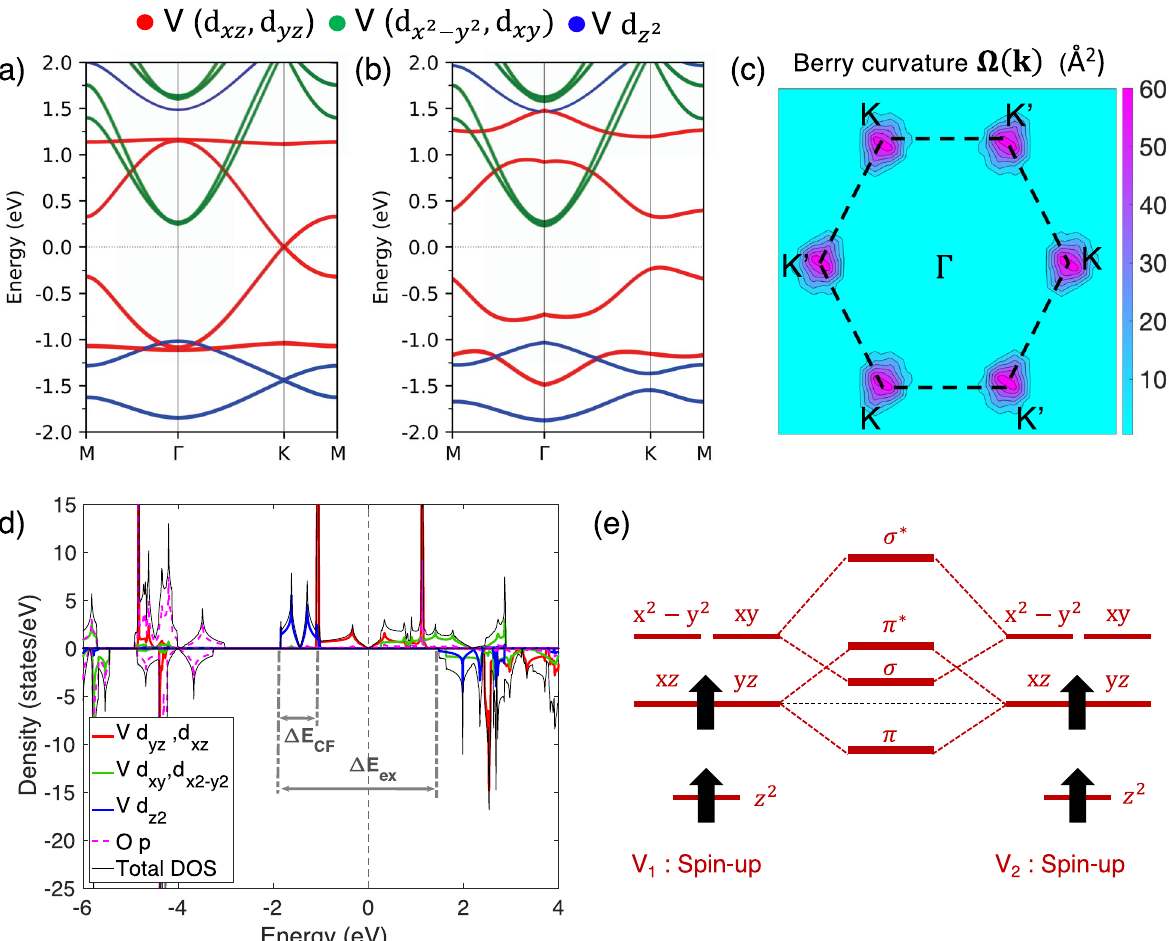
Fig. 3 Electronic band structure with derived orbital and topological character. a The electronic band structure within GGA + U without SOC and ( b ) with SOC. c The calculated Berry curvature projected onto the BZ. d The orbital- and spin-resolved DOS. e The derived orbital ordering and bonding of the spin-polarized V 3 d